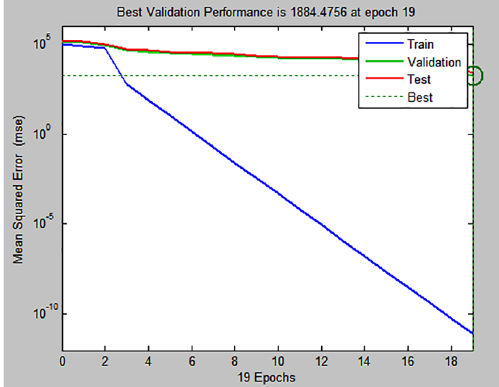
Figure 13. Performance validation chart